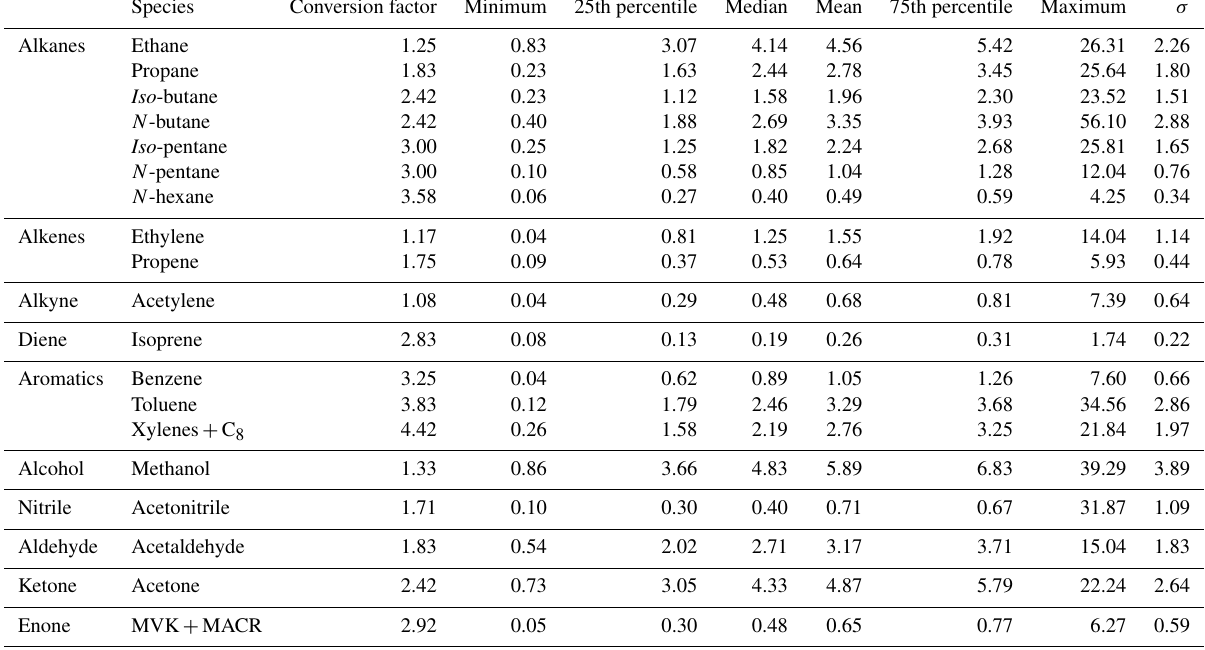
Table 1. Statistical summaries (µgm − 3 ) of selected VOC concentrations measured at urban background sites. Statistics were calculated from hourly mean data, initially obtained every 30min (ethane > isoprene) and every 5 to 10min (for aromatics and OVOCs). These measurements were undertaken from 15 January to 22 November 2010 ( ∼ 10 months). A conversion factor is provided here to convert VOC concentrations (µgm − 3 ) into (ppb) mixing